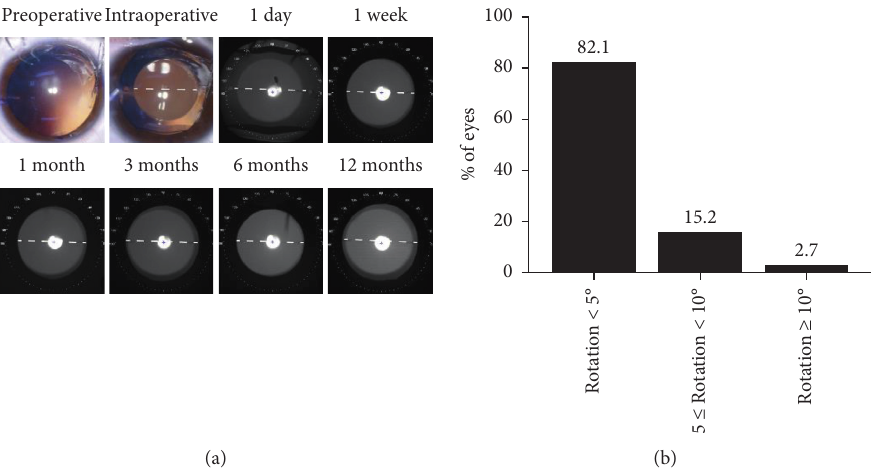
Figure 1: Presentation of the TICL axis after surgery. (a) Preoperative, intraoperative, and postoperative placement of the TICL. (b) Distribution of the TICL rotation at 12 months after